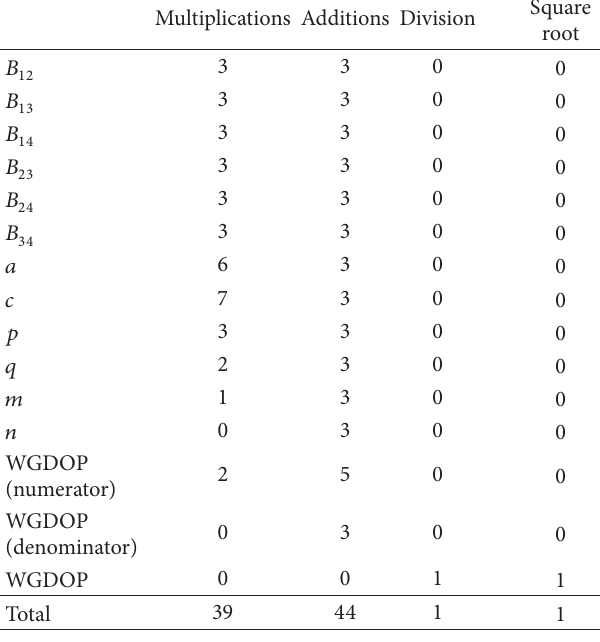
Table 2: The complexity of WGDOP calculation when the four measurements have two types of error